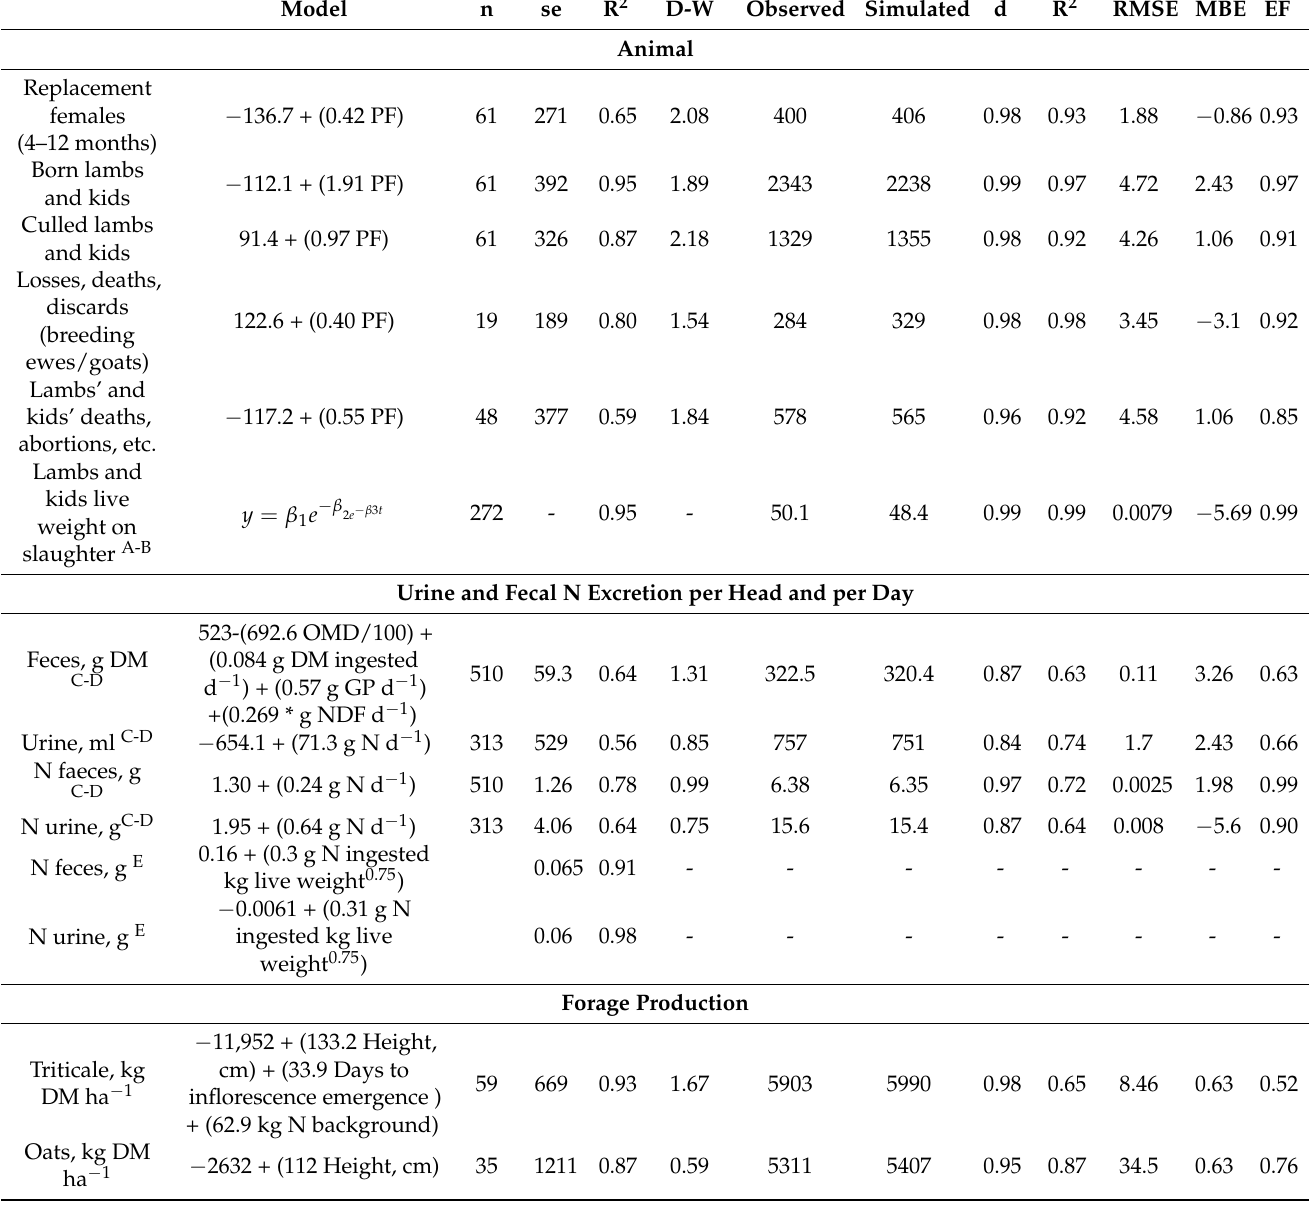
Table 5. Statistical evaluation of the models for the estimation of the number of animals and manure and forage